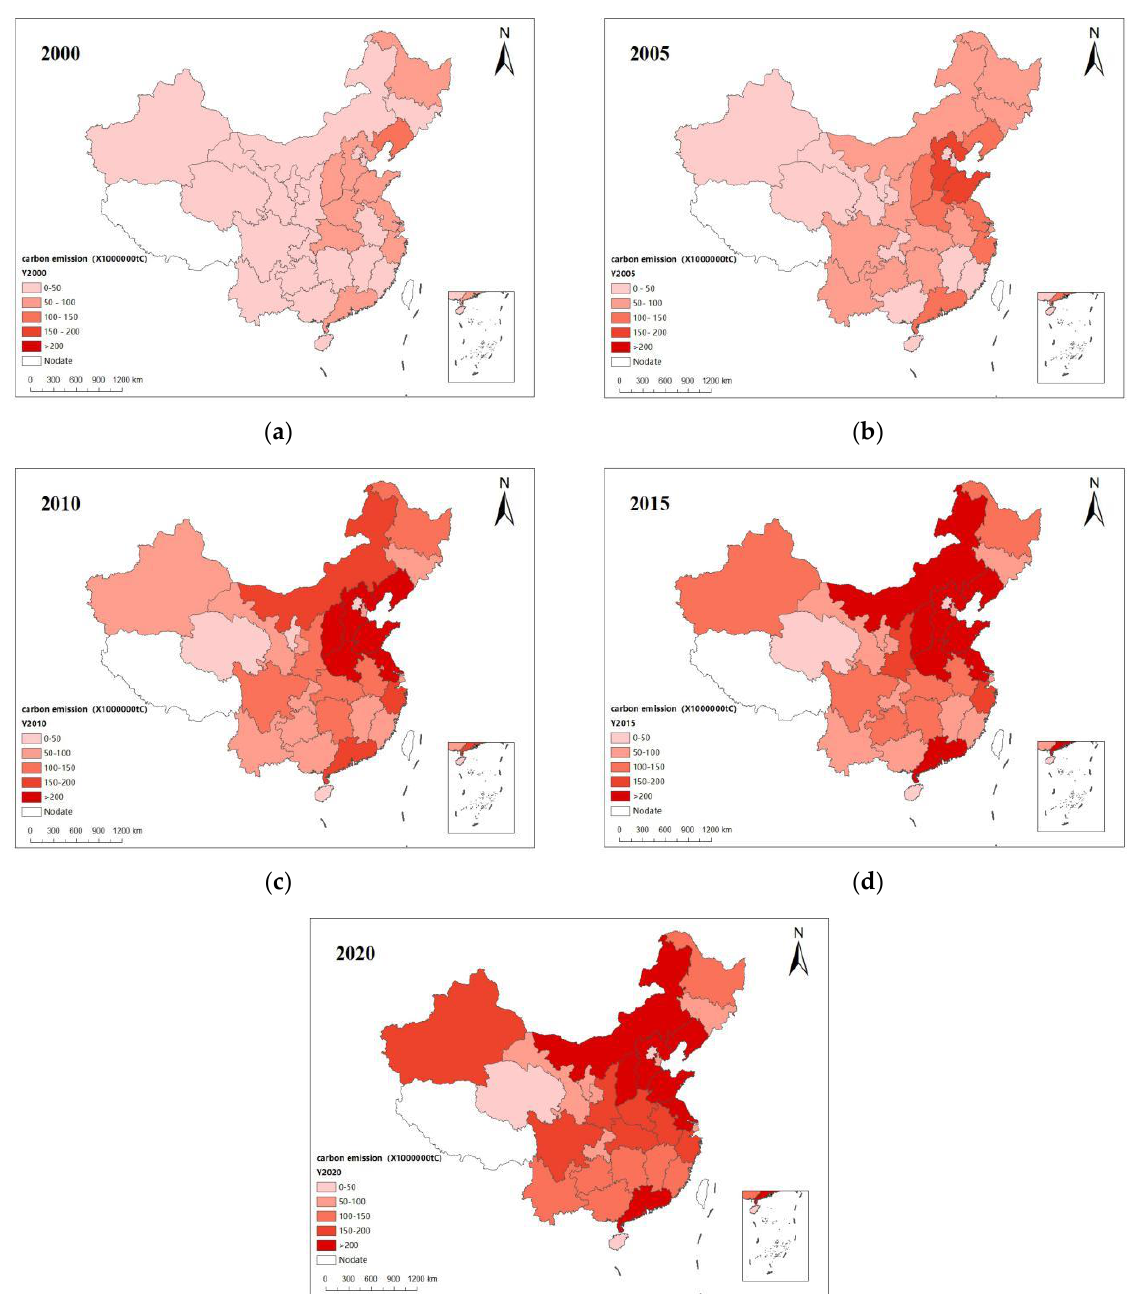
Figure 3. Temporal and spatial dynamics of carbon emissions by province in China from 2000 to 2020. Among them, ( a ) represents the spatial distribution pattern of China’s carbon emissions in 2000, ( b ) represents the spatial distribution pattern of China’s carbon emissions in 2005, ( c ) represents the spatial distribution pattern of China’s c arbon emissions in 2010. ( d ) represents the spatial distribution pattern of China’s carbon emissions in 20 15. ( e ) represents the spatial distribution pat- tern of China’s carbon emissions in 20 20.